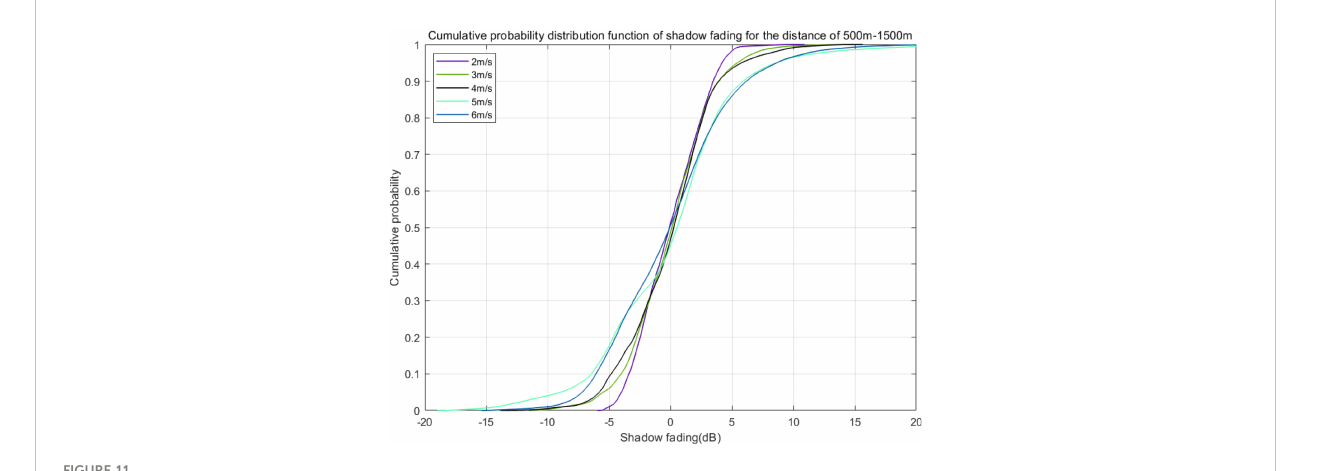
FIGURE 11 CDF of the shadow fading for Area